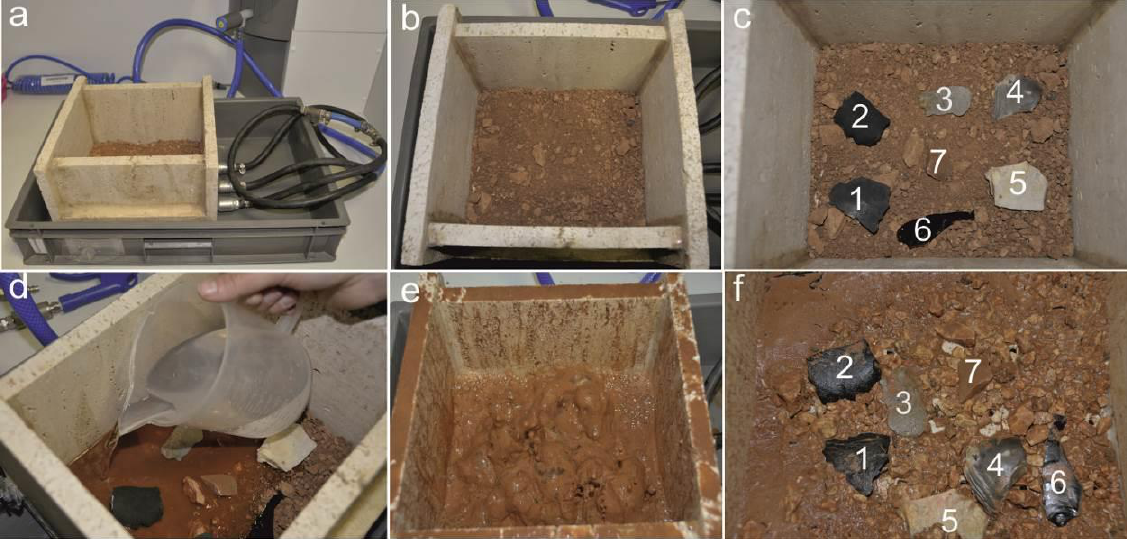
Figure 5. Tumbling experiment: a) travertine tank connected to air source; b) sediment filling; c) experimental pieces on top of sediment layer and their initial distribution; d) covering sediment and flakes with water; e) intensive “boiling” effect; f) distribution of experimental flakes after five